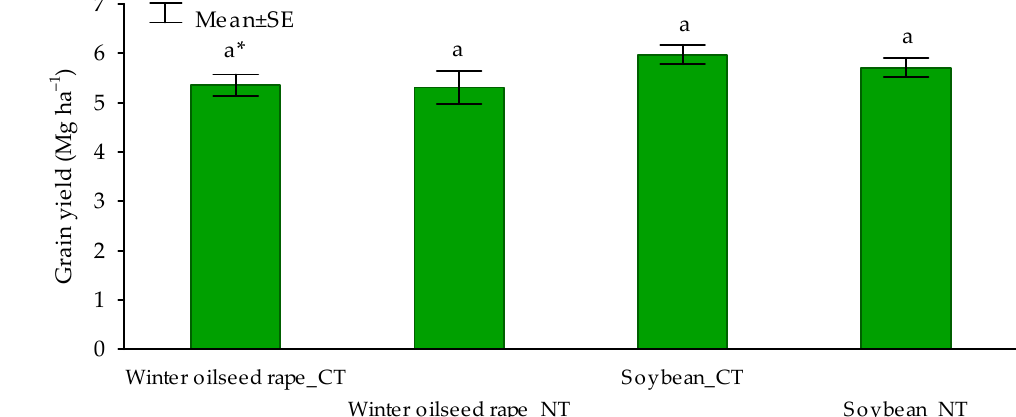
Figure 2. Interactive dependencies of previous crop and tillage system in determining winter wheat grain yield (mean for